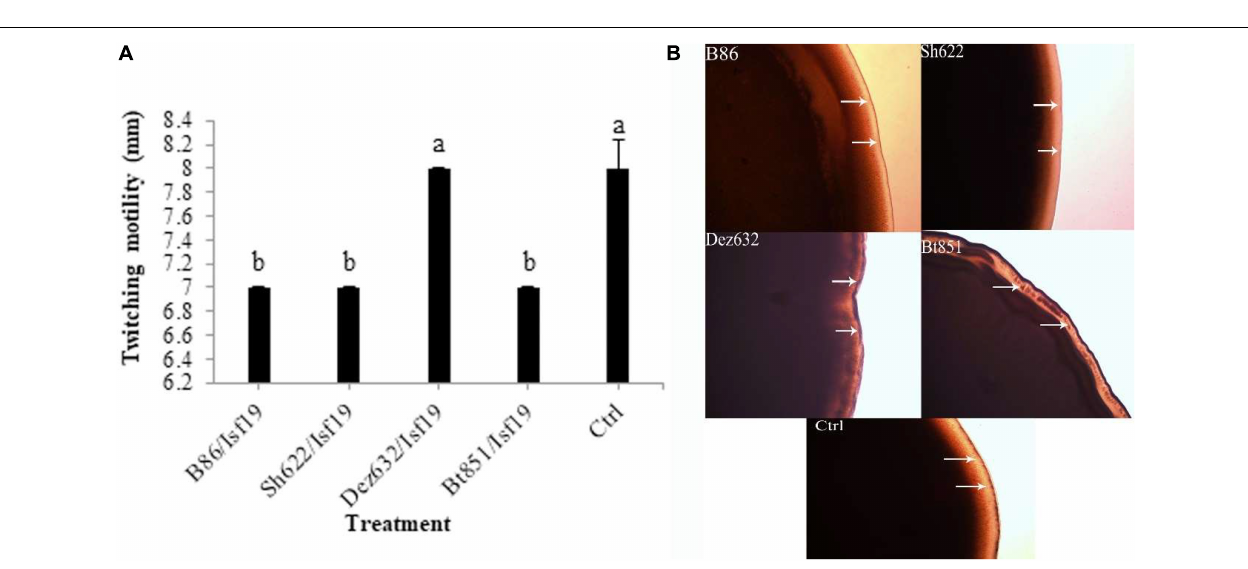
FIGURE 3 | Effects of VOCs produced by Streptomyces sp. B86 , Pantoea sp. Dez632 , Pseudomonas sp. Bt851, and Stenotrophomonas sp. Sh622 on swimming motility of B. pumilus Isf19 compared to the non-treated control (Ctrl). The diameter of motility zone (A) and representative plate of swarming motility assay (B) were shown. Three replicates were used for each treatment. Error bars indicate the SE of the three replicates. Different letters indicate significant differences ( P = 0.05).